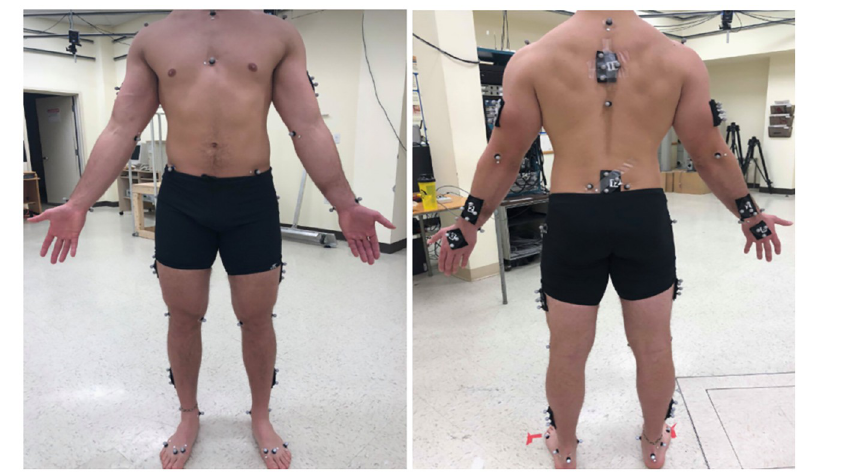
Fig 2. Experimental markers initially located on each